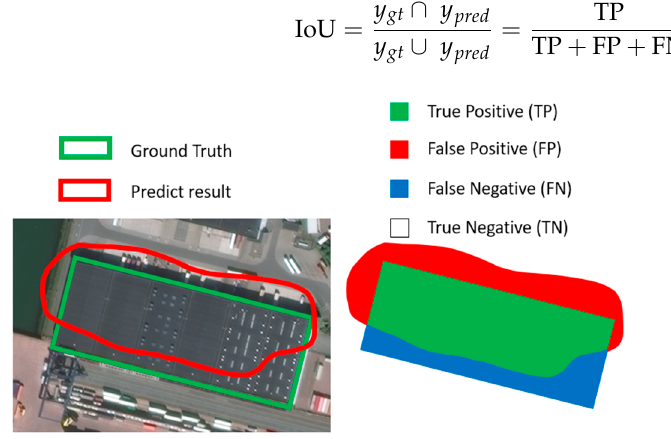
Figure 5. How IoU is calculated over an optical image of a warehouse building. True Positives (TP) are pixels labeled as building and are correctly predicted as building. True Negatives (TN) are pixels labeled as background and are correctly predicted. False Negatives (FN) are misclassified background pixels, while False Positives (FP) are misclassified pixels of buildings.